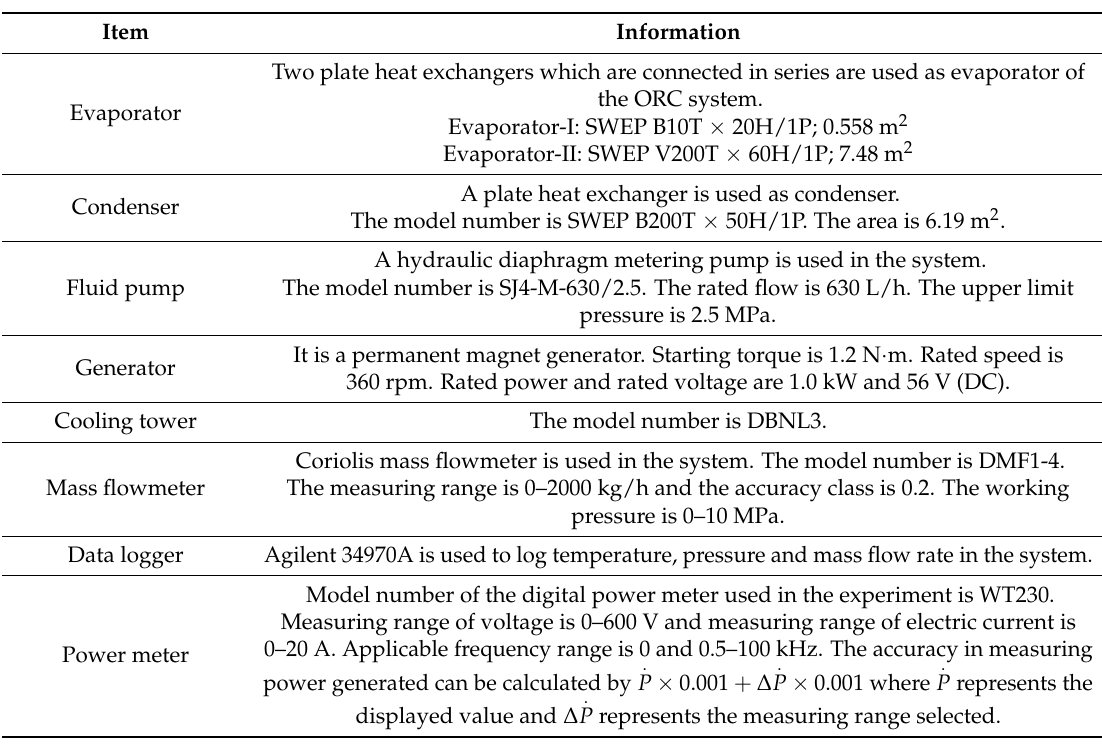
Table 1. Information of instruments and measuring devices.